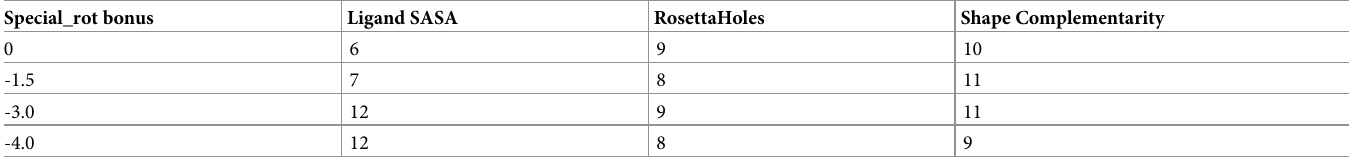
unmodified Packer. Shape complementarity is considered improved if the median increased relative to the unmodified